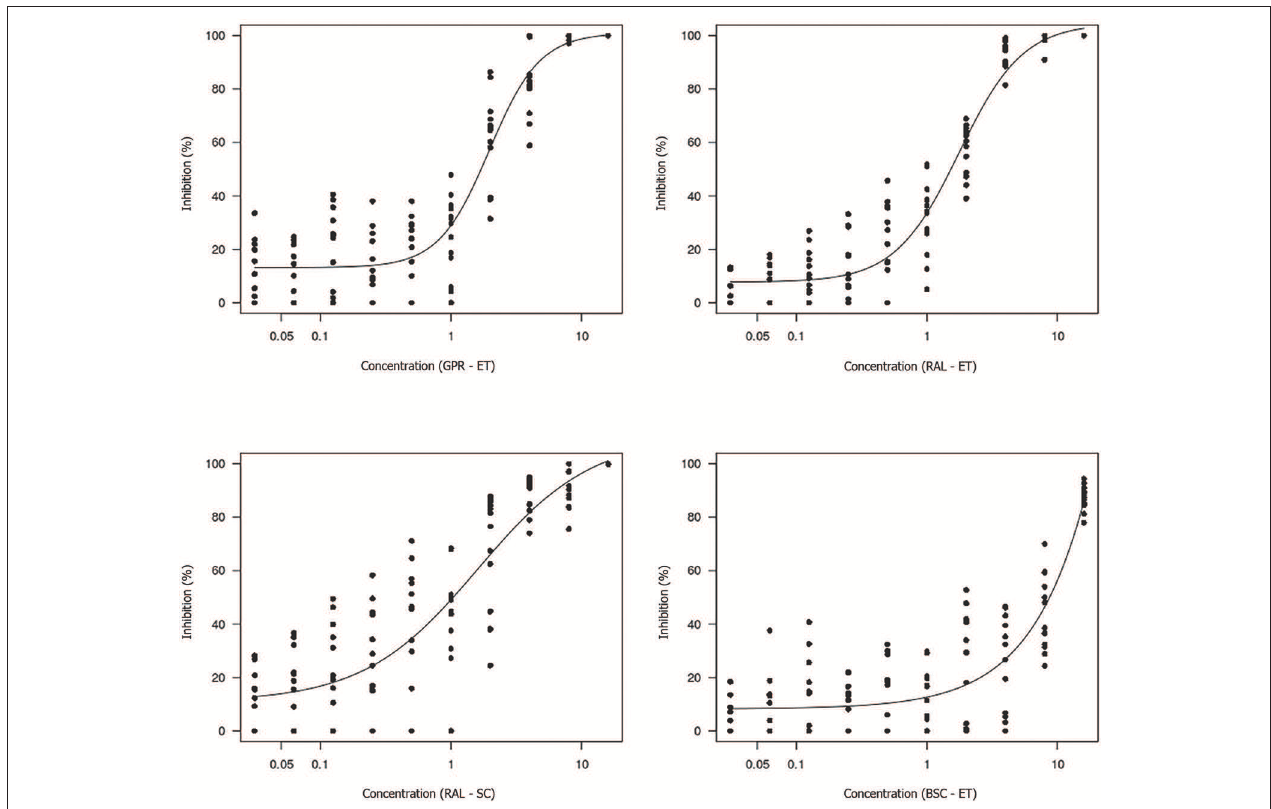
FIGURE 4 | Dose-response curve for each propolis extract tested using the broth microdilution technique for determining the EC 50 value of M. pachydermatis isolates. GPR–ET, green propolis ethanolic extract from Paraná, Brazil; RAL–ET, red propolis ethanolic extract from Alagoas, Brazil; RAL–SC, red propolis supercritical extract from Alagoas, Brazil; BSC–ET, brown propolis ethanolic extract from Santa Catarina, Brazil. The results are expressed in mg/mL. formononetin and medicarpine act as chemical biomarkers